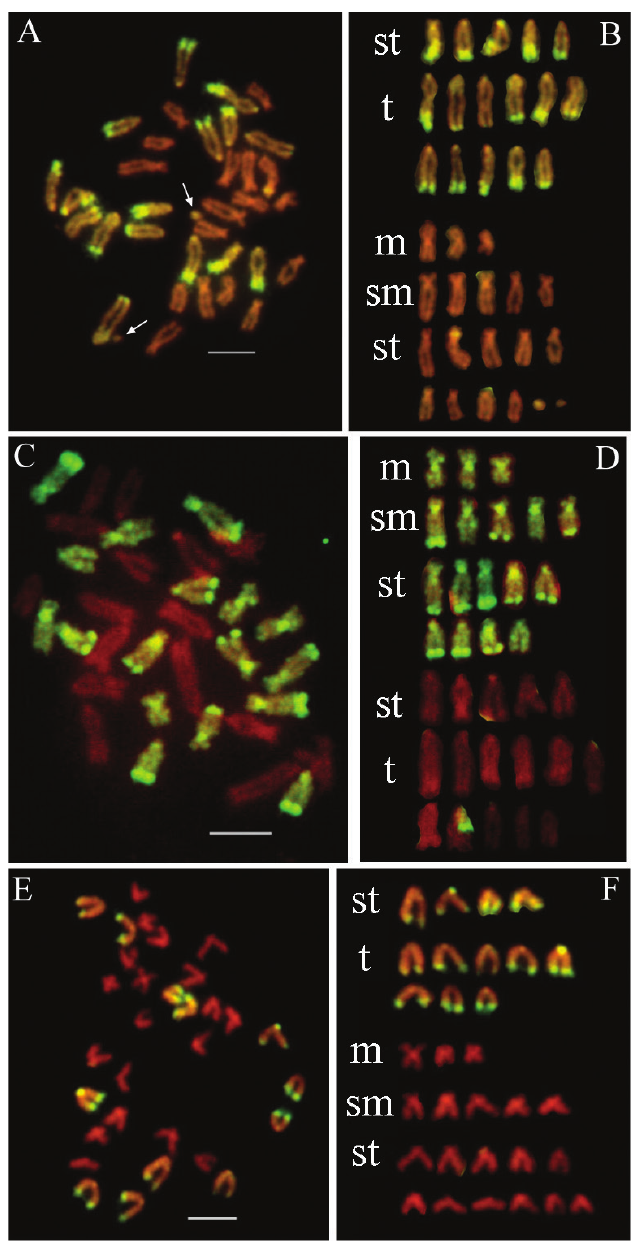
Figure 2. Examples of chromosome fragments ( A, B ) and chromosome eliminations ( C, D, E, F ) in the F1 hybrids. In ( A, B ), chromosome fragments originated from C. farreri were marked with arrows. In ( C, D ), some chromosomes from C. farreri eliminated in the metaphase spread. In ( E, F ), some chromosomes from A. i. irradians eliminated in the metaphase spread. In ( A, B, E, F ), chromosomes were labeled by GISH using A. i. irradians genomic DNA probes (green). In ( C, D ), chromosomes were labeled by GISH using C. farreri genomic DNA probes (green). Bars = 5